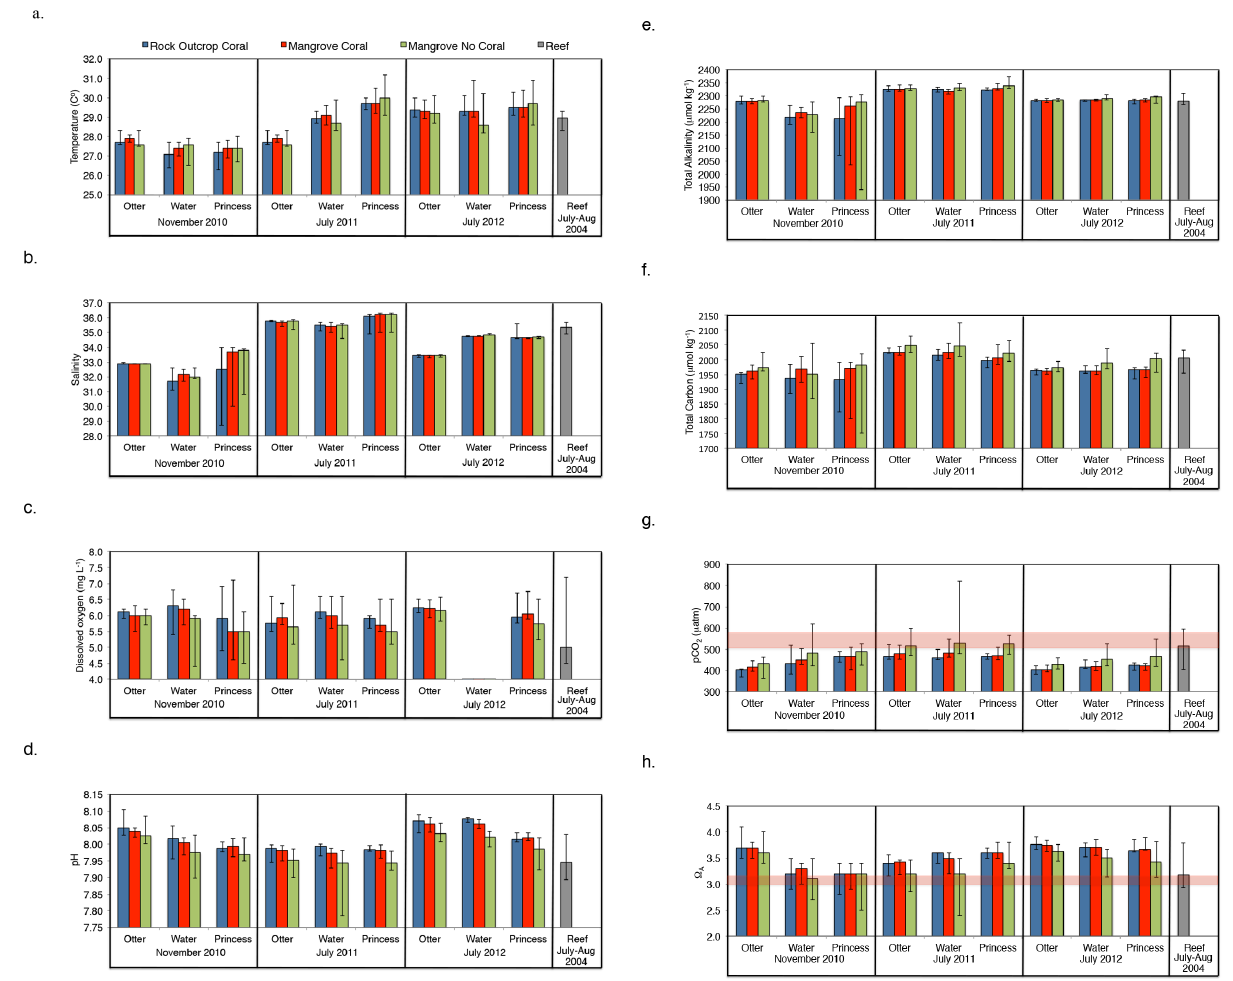
Figure 3. Chemical and physical parameters. Median and range for chemical and physical parameters in Hurricane Hole bays during Novem- ber 2010, July 2011, and July 2012 and for Long Bay reef during July and August 2004 ( n = 10). Measurements were made every 4h throughout a diurnal cycle ( n = 7) at each study site during November 2010 and July 2011, and July 2012, and for 3 consecutive days ( n = 19) in Otter Creek during July 2012. Measurements at Long Bay reef were made at 07:00 and 11:00 ( n = 7 and 3, respectively). No DO data were collected in Water Creek during July 2012 due to DO sensor failure. Red shaded areas (3g and 3h) show reported ranges for p CO 2 and (cid:127) A thresholds for carbonate calcification and dissolution. Data and latitude/longitude of study sites are available at